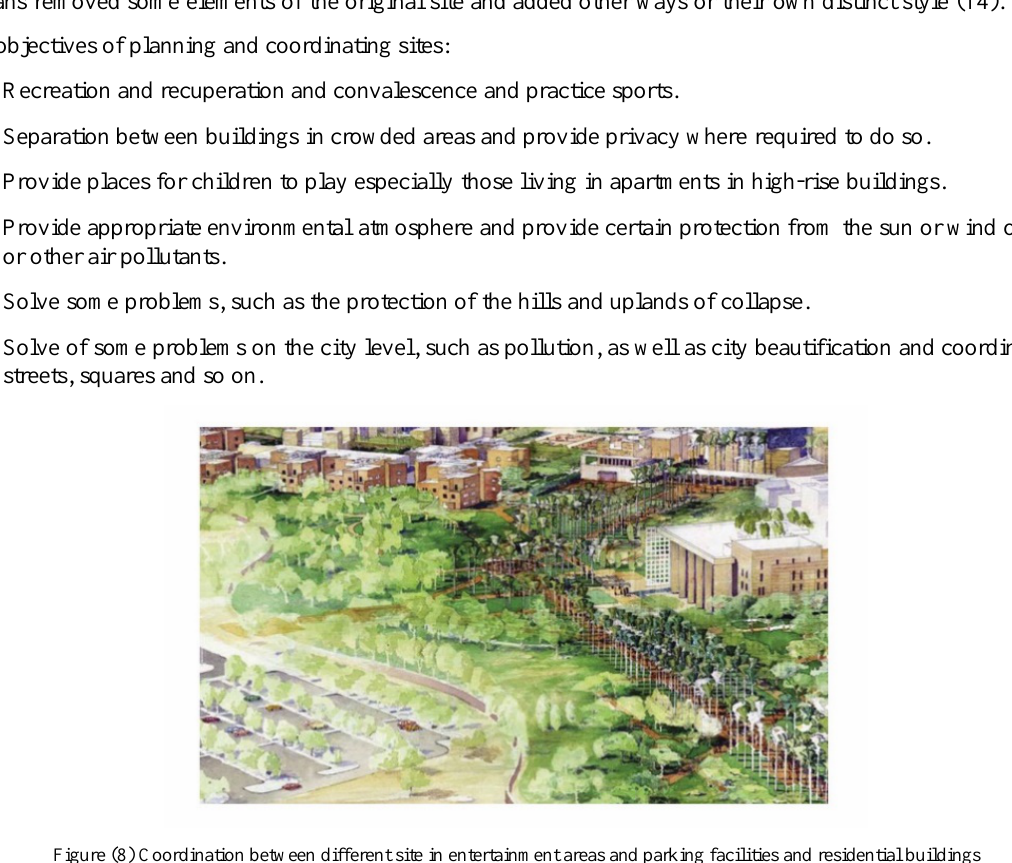
Figure (8) Coordination between different site in entertainment areas and parking facilities and residential buildings Classification of open spaces and